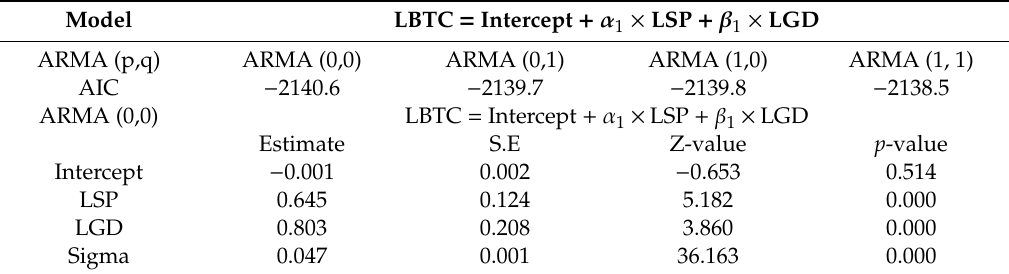
Table 9. Selection of p and q for ARMA based on AIC of 4 cases of (0, 0), (0, 1), (1, 0), and (1, 1). ARMA (0, 0) is selected based on AIC criteria. CMR model fit of LBTC with LSP and LGD with error dependence structure ARMA (0, 0).